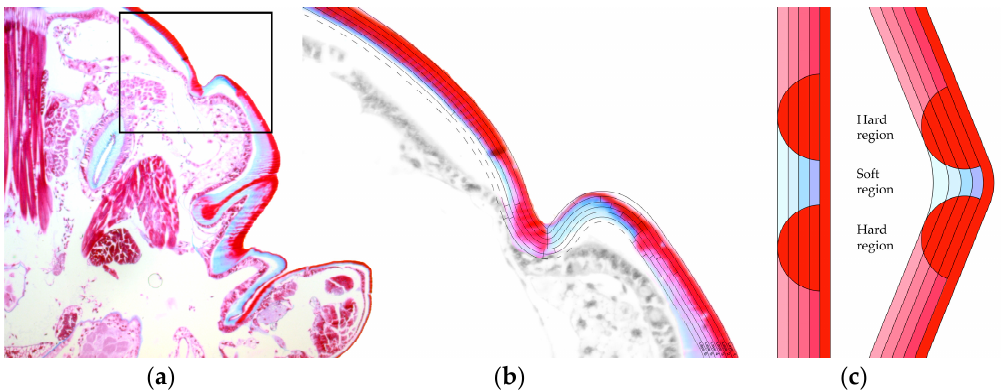
Figure 3. A section through the exoskeleton of a flea in detail in ( a ) and magnified in ( b ). These two photographs were taken by the authors at the Department of Evolutionary Biology of Invertebrates at the University of Tübingen. Abstracted representation of the hinge zone in flat and folded state ( c ). The reinforced edge is shown as semi-circles along the fold, while the colors show the differentiation between the harder exocuticle (red) and softer endocuticle (blue), where the deformation takes place.